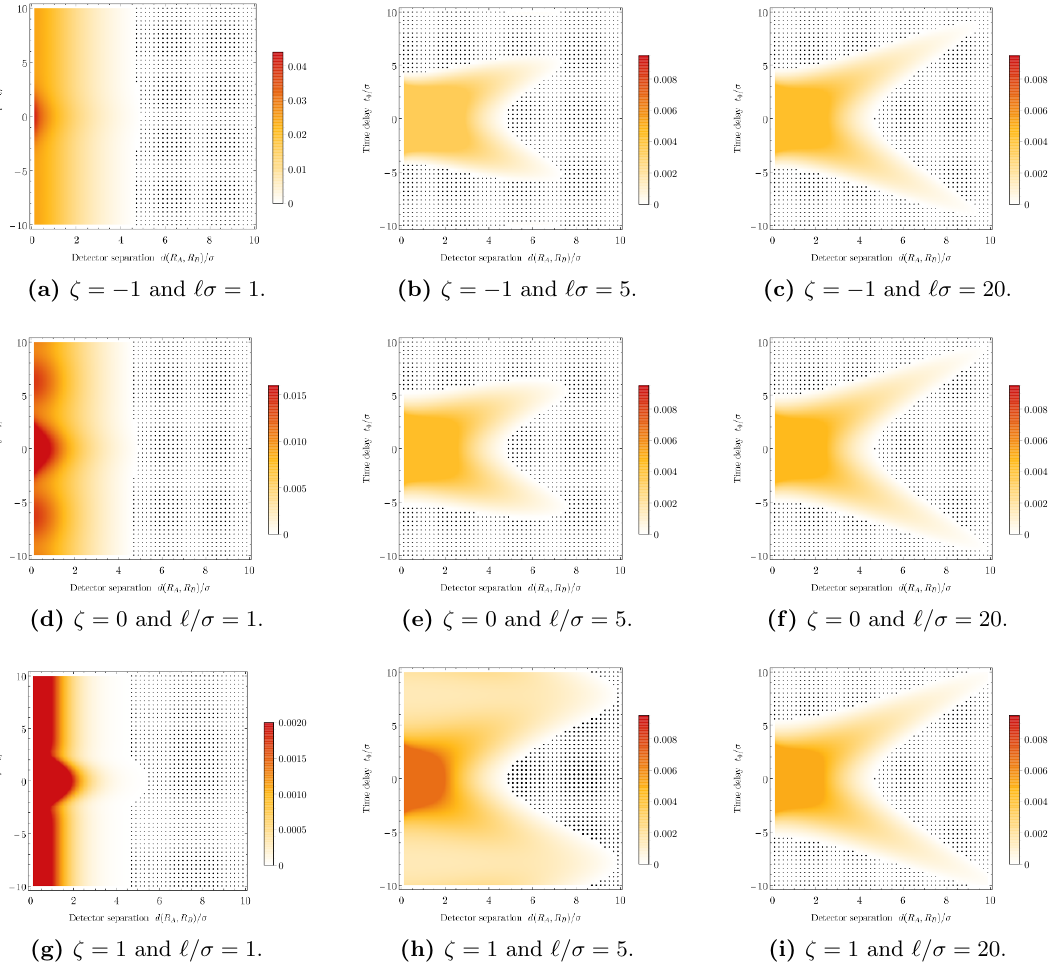
Figure 17 . The concurrence, C = ~ (cid:21) 2 associated with the state (cid:26) AB describing two detectors on circular geodesic orbits around the origin is plotted as a function of their proper separation d ( R A ; R B ) =(cid:27) and the relative time delay in their switching functions t 0 =(cid:27) for all boundary con- ditions (cid:16) = f(cid:0) 1 ; 0 ; 1 g and di(cid:11)erent values of the AdS length ‘=(cid:27) . A negative t 0 corresponds to detector B switching before detector A . Detector A is located at the origin and the energy gap of the detectors is (cid:10) (cid:27) = 2. The area (cid:12)lled with black dots represents the region where the concurrence vanishes and thus no entanglement harvesting is